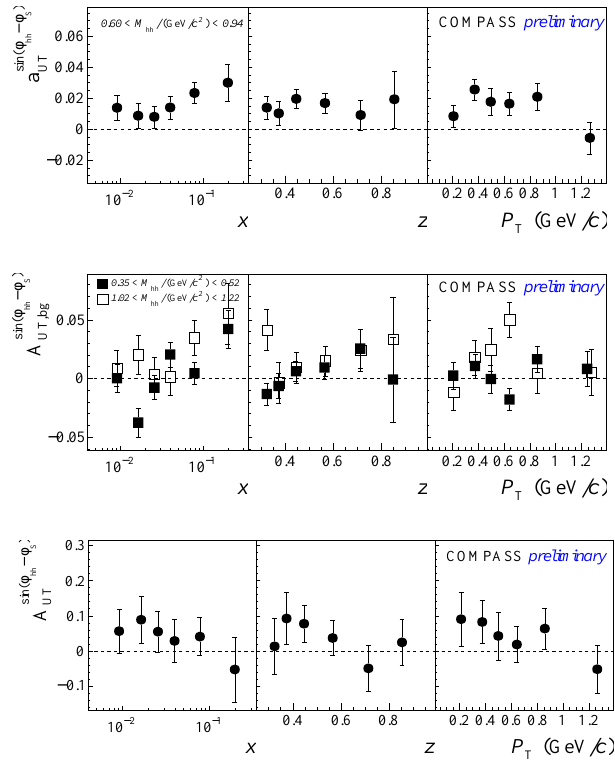
Figure 4: Upper panel: Sivers asymmetry in region I I as function of x (left plot), z (middle plot) and P (right plot). Middle panel: corresponding asymmetries in re- T gion I (full points) and I I (open points). Lower panel: final Sivers asymmetry for ρ 0 mesons. Statistic uncertainties only. Systematic uncertainties for the ρ 0 asymmetry = 0.3 σ have been estimated to be σ sys stat